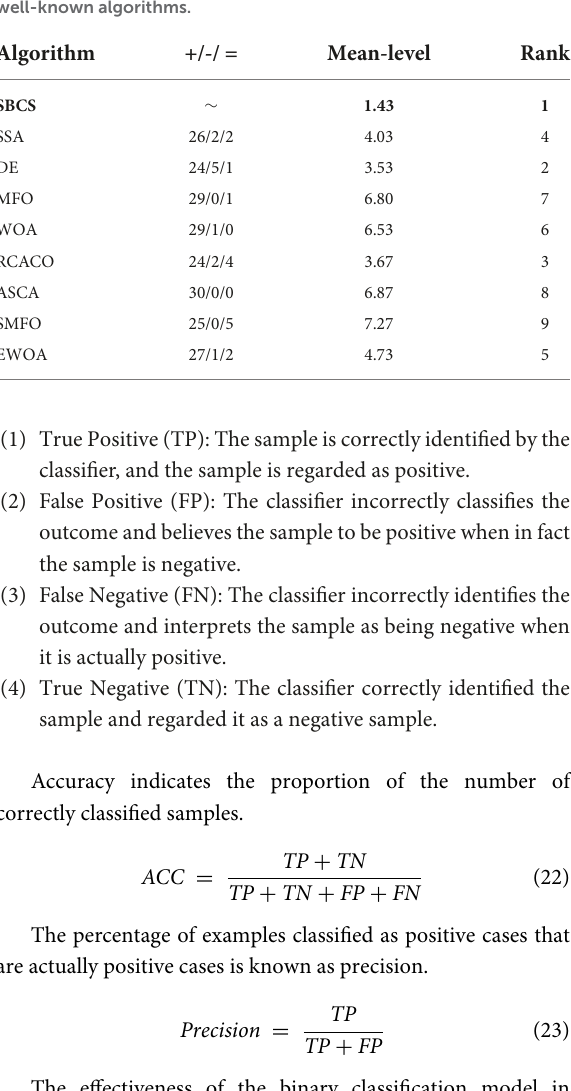
TABLE 8 Performance ranking of SBCS with other well-known